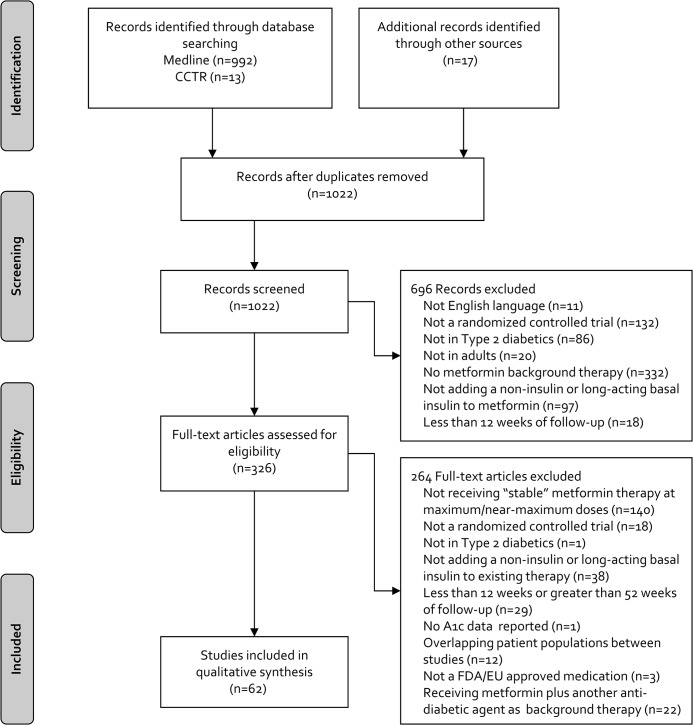
Results of the Literature Search.CCTR = Cochrane controlled trials register; EU = European Union; FDA = Food and Drug Administration; HbA1c = hemoglobin A1c.